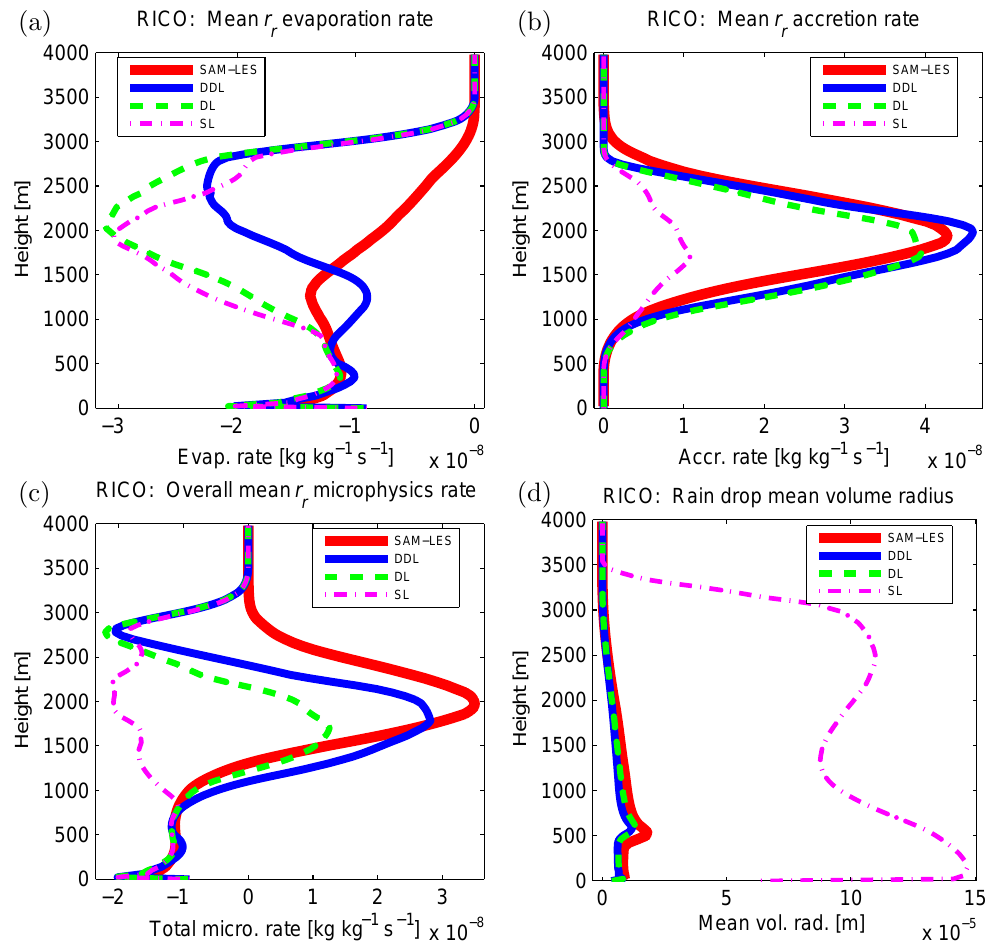
Figure 7. Profiles of mean microphysics process rates in the RICO precipitating shallow cumulus case time-averaged over the last 2 hours of the simulation (minutes 4200 through 4320). The SAM LES results are red solid lines, the DDL results are blue solid lines, the DL results are green dashed lines, and the SL results are magenta dashed-dotted lines. (a) The mean evaporation rate of r r . (b) The mean accretion rate of r r . (c) The overall mean microphysics tendency for r r . (d) The mean volume radius of rain drops. Overall, the DDL provides a better fit to SAM LES than the DL, which in turn provides a better fit than the